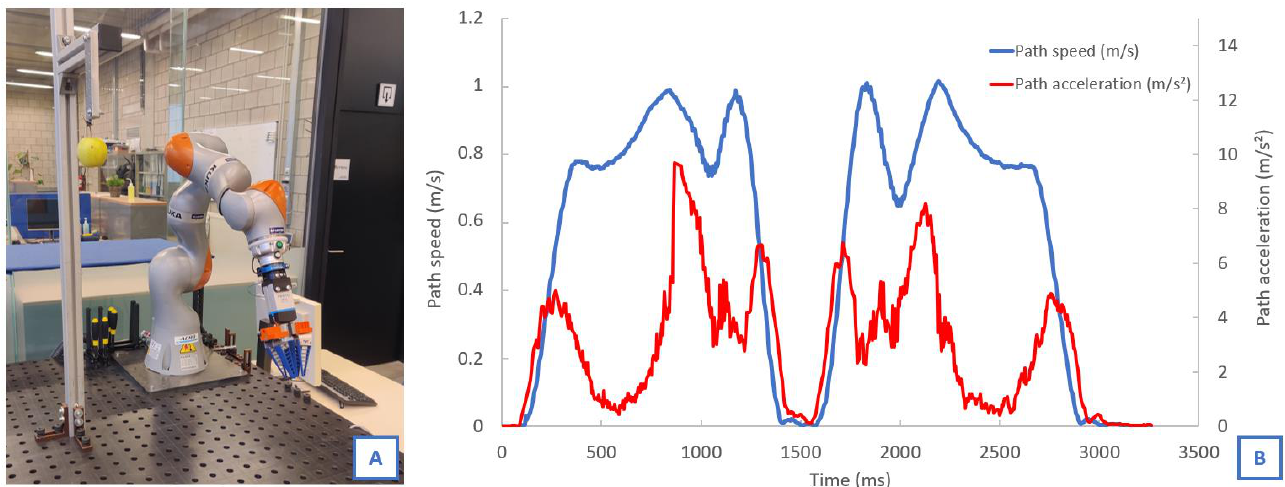
Figure 2. The used testing setup with the KUKA iiwa 14 R820 ( A ) and Velocity and acceleration diagram of the end effector along the movement path during one testing sequence ( B ).